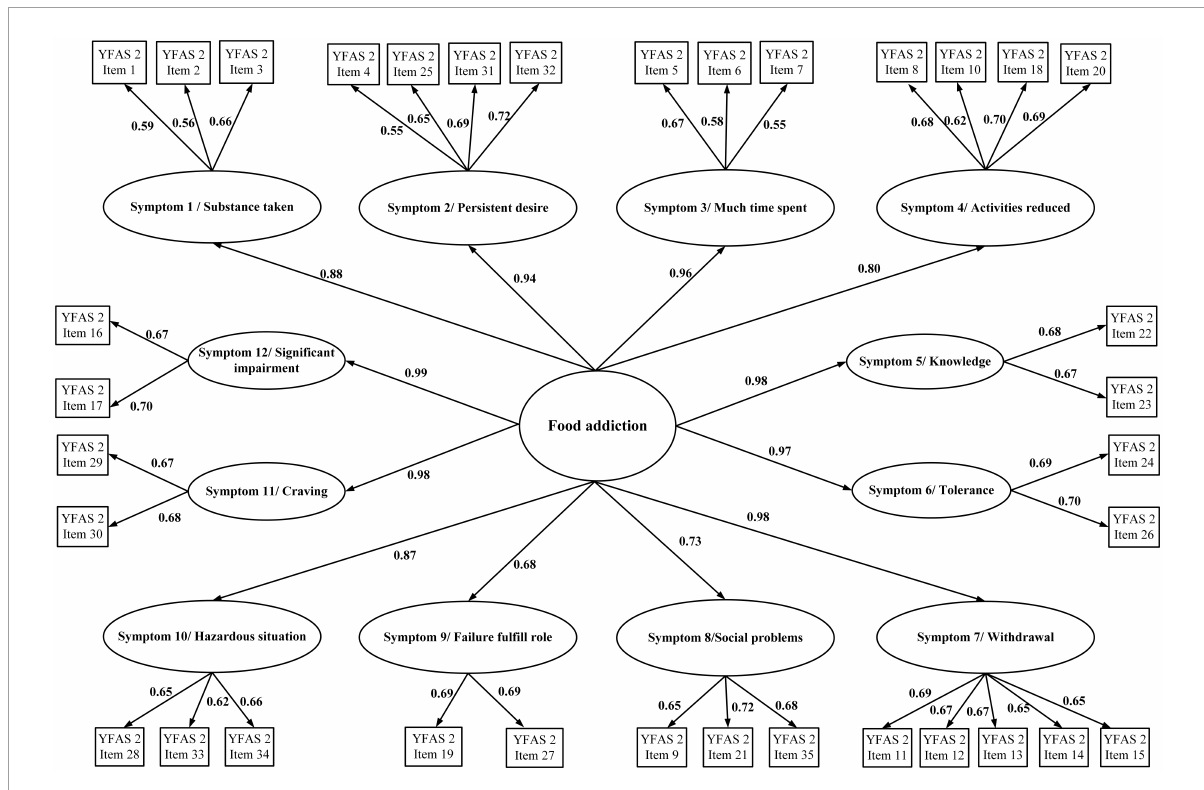
FIGURE2 Confirmatory factor analysis (CFA) to examine the second-order structure of the YFAS 2.0. Data are presented as factor loadings (aka standardized